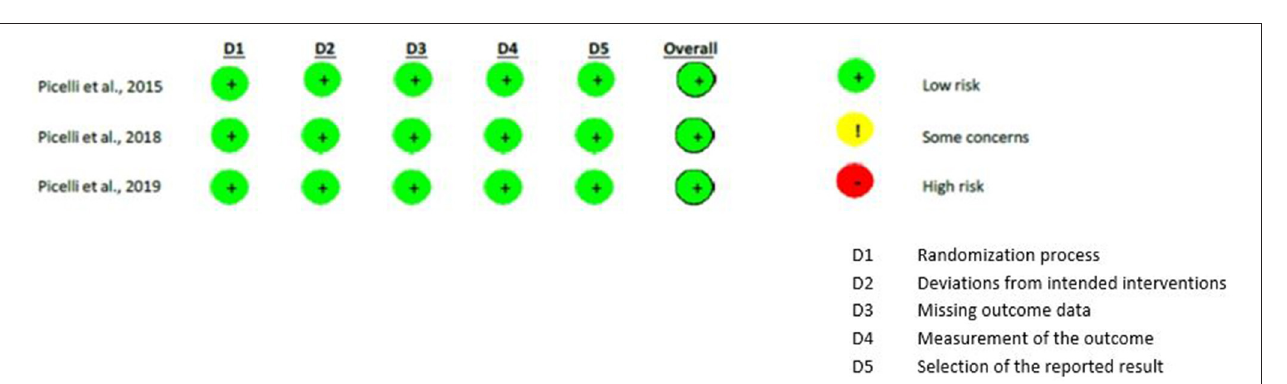
FIGURE 2 | Assessment of Risk of Bias in real versus sham studies.